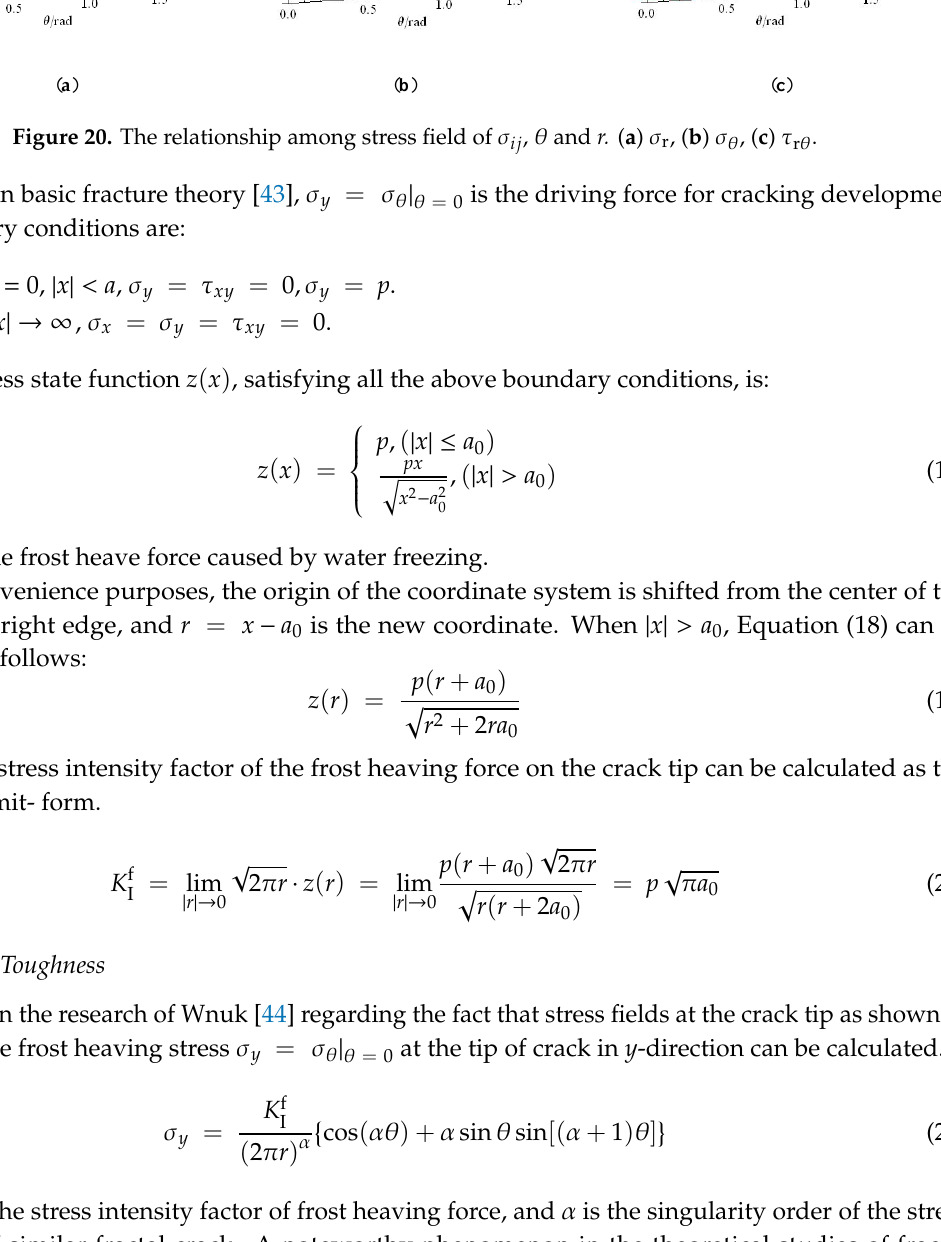
Figure 20. The relationship among stress field of σ